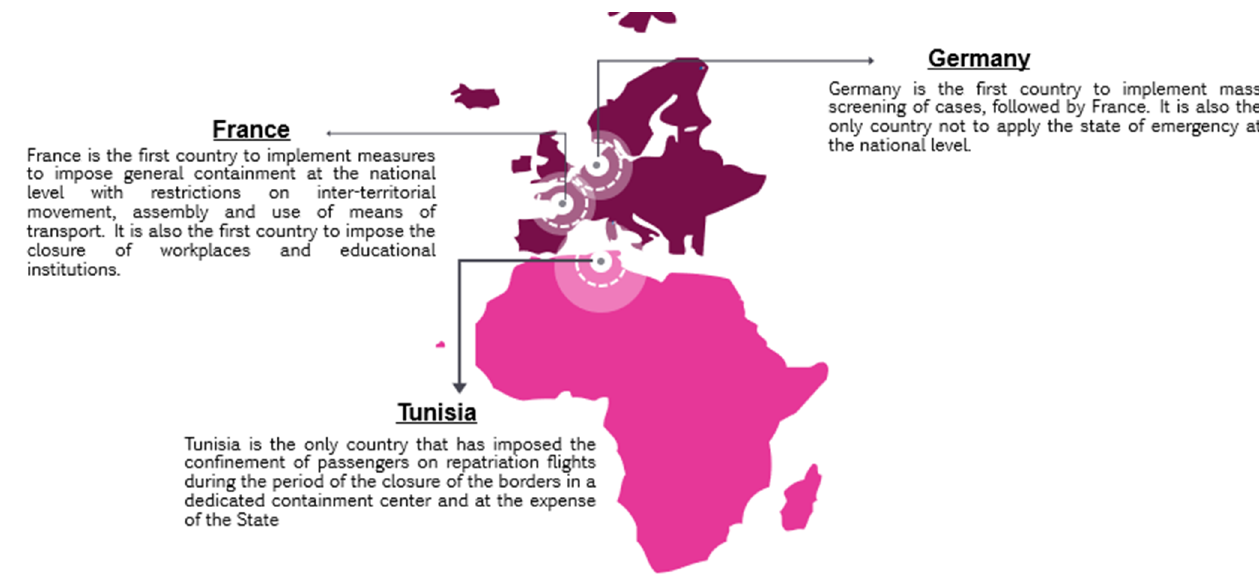
Figure 4. Mapping of the main differences in the national strategies of Tunisia, France, and Germany.